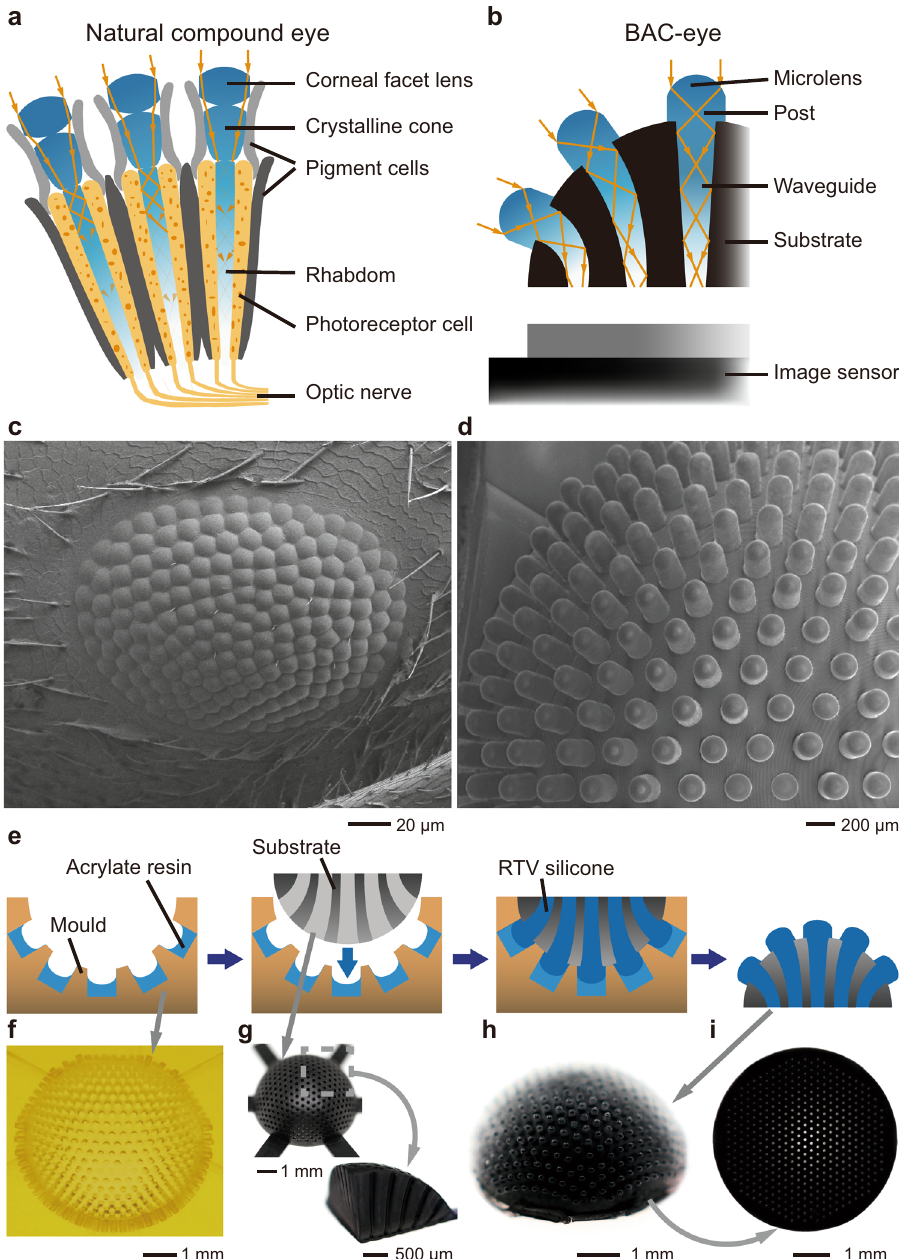
Fig. 1 Illustrations of the fabrication procedure and images of the BAC-eye. a Anatomical structure of an arthropod compound eye. b Labelled cross section of a BAC-eye. c SEM image of a compound eye of the Asian needle ant, Brachyponera chinensis . d SEM image of a BAC-eye. e Illustration of the main steps of the fabrication procedure. The BAC-eye is produced in a hemispherical substrate by casting it in a prepared mould. f Image of the 3D-printed mould. g The 3D-printed substrate and a quarter sectional slice of the substrate. h Image of a BAC-eye after release from the mould. i A view showing the fl at bottom of the